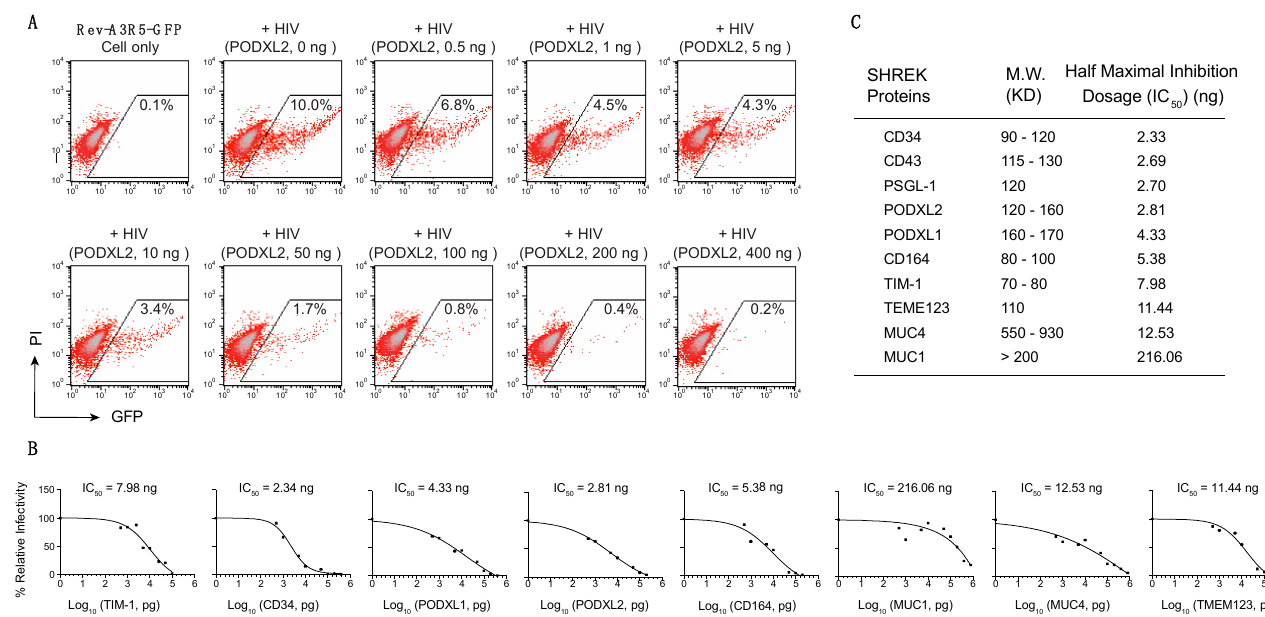
Figure 2. ( A ) Dose-dependent inhibition of HIV-1 infectivity by PODXL2. HEK293T cells were cotransfected with pHIV(NL4-3) DNA (1 µg) plus the PODXL2 expression vector (0.5 to 400 ng of DNA). Virions were harvested at 48 h and normalized for p24, and viral infectivity was quantified by infecting Rev-A3R5-GFP indicator cells. ( B ) Virions were assembled in the presence of each individual SHERK protein, and quantified for virus infectivity as in ( A ). The dose-dependent inhibition of HIV-1 curve by each individual SHREK protein was plotted using results from 2 independent experiments. ( C ) The 50% inhibition dosage (IC 50 ) for each SHREK protein was calculated based on the averages from the two independent experiments.